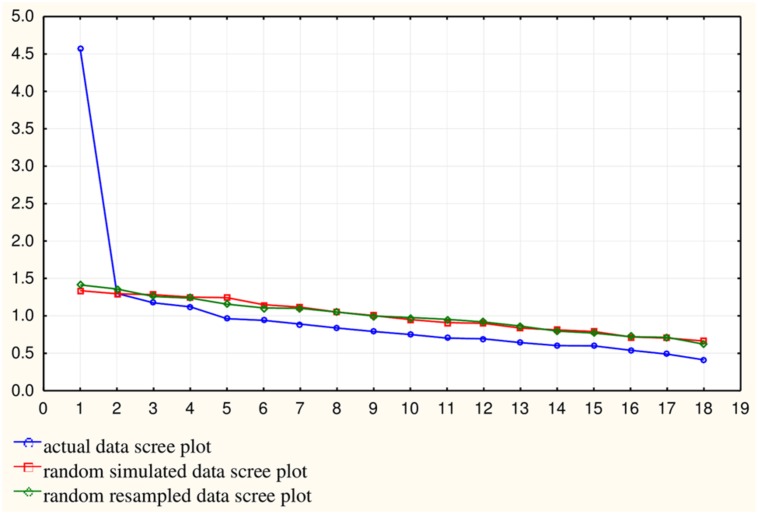
Scree plot with parallel analysis results. It indicates the number of factors to be retained. The blue scree plot represents the scree plot from the actual data while the red and green scree plots represent randomly simulated data with the same dimensions as the actual data. This figure clearly indicates one-factor and the possibility of two factors, as the first factor lies clearly above the random scree plots and the second factor lies directly on the random scree plots.